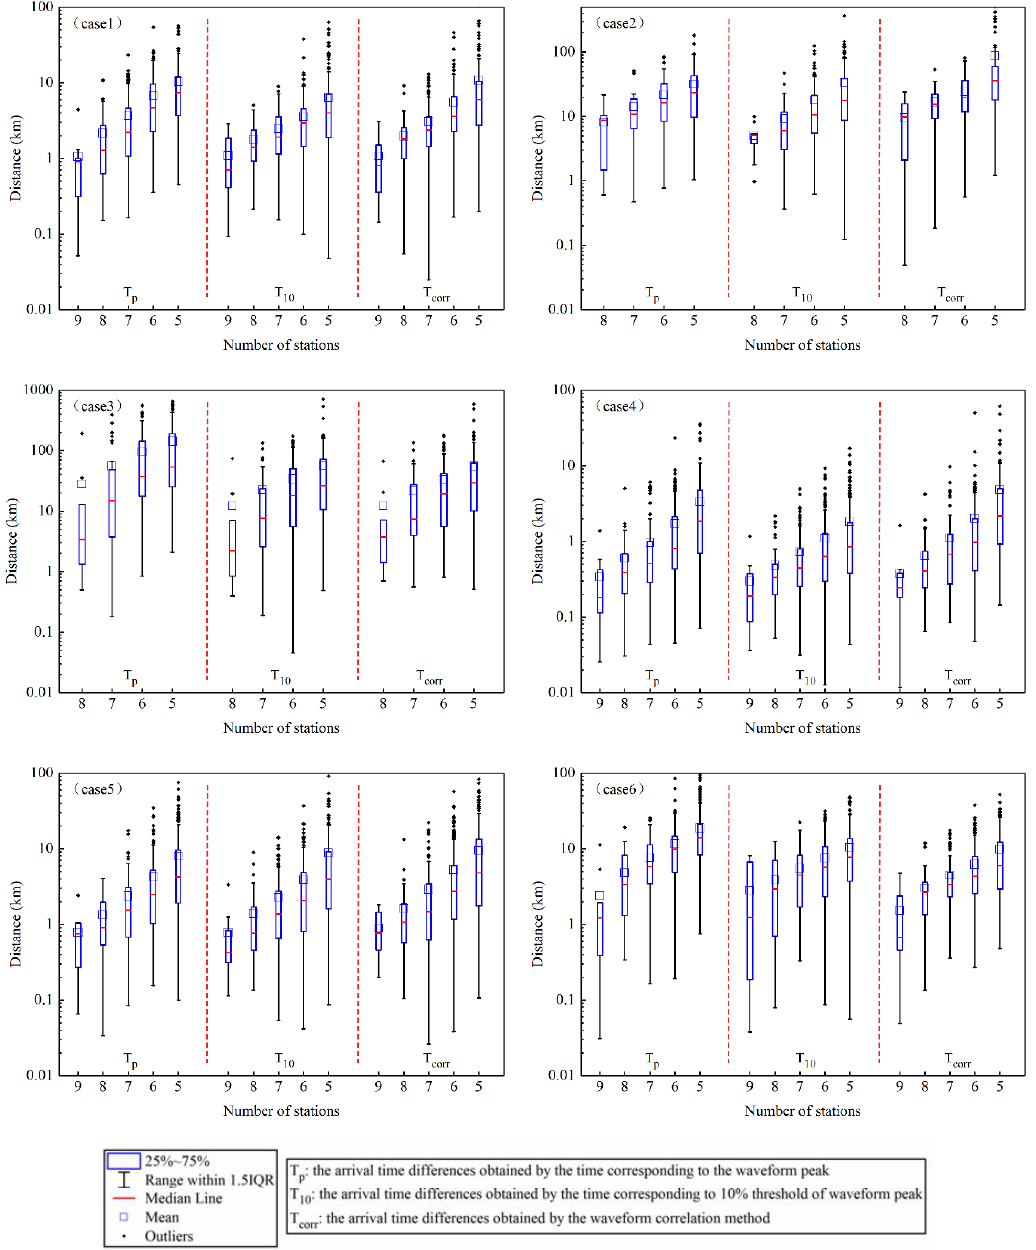
Figure 6. The deviation distance of six cases between the reference location and the location under different number and configuration of stations using the ToA technique with three definitions of arrival time differences.